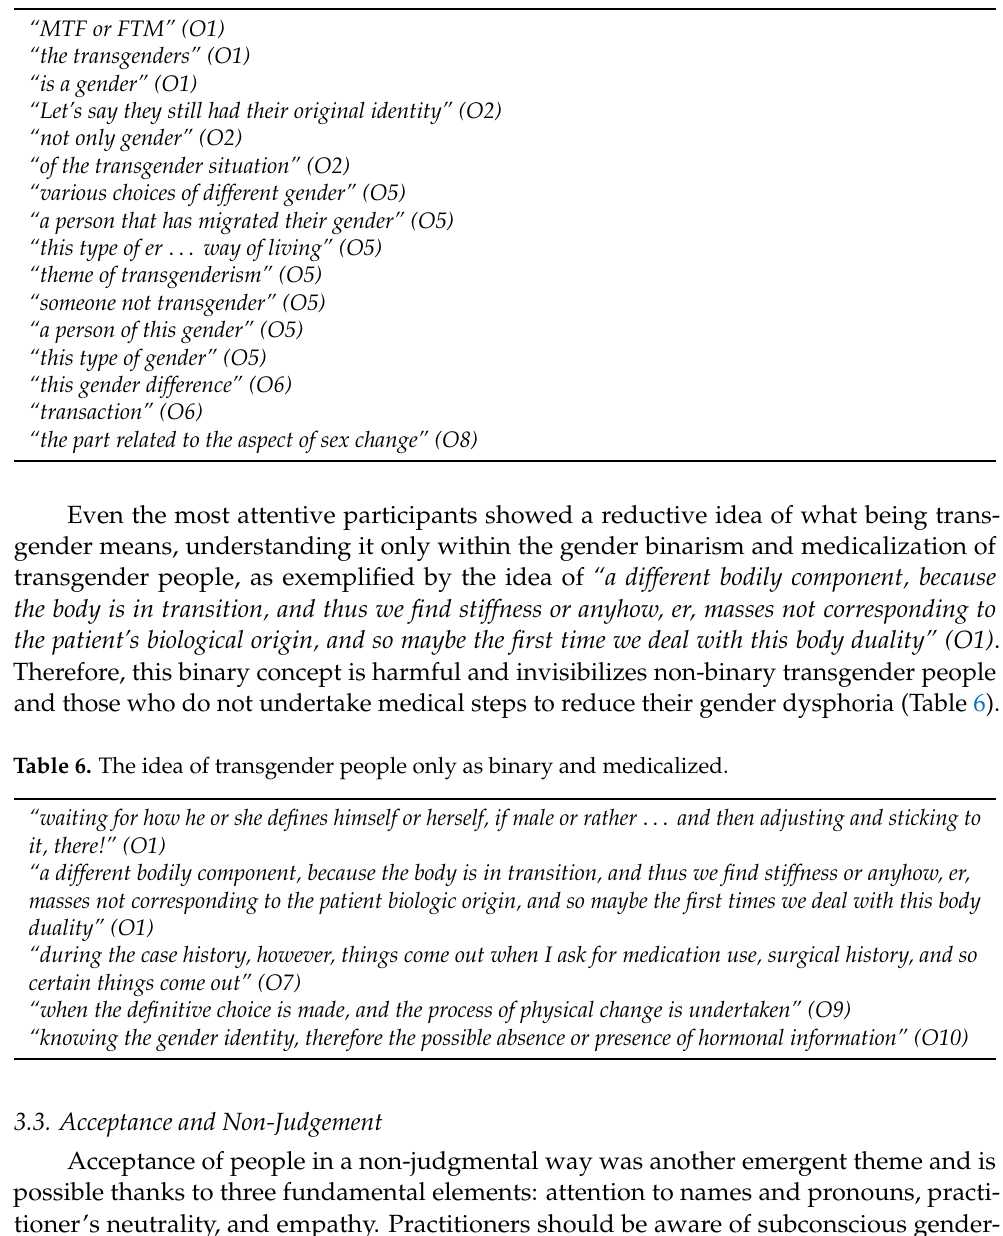
Table 5. Improper language and reification.